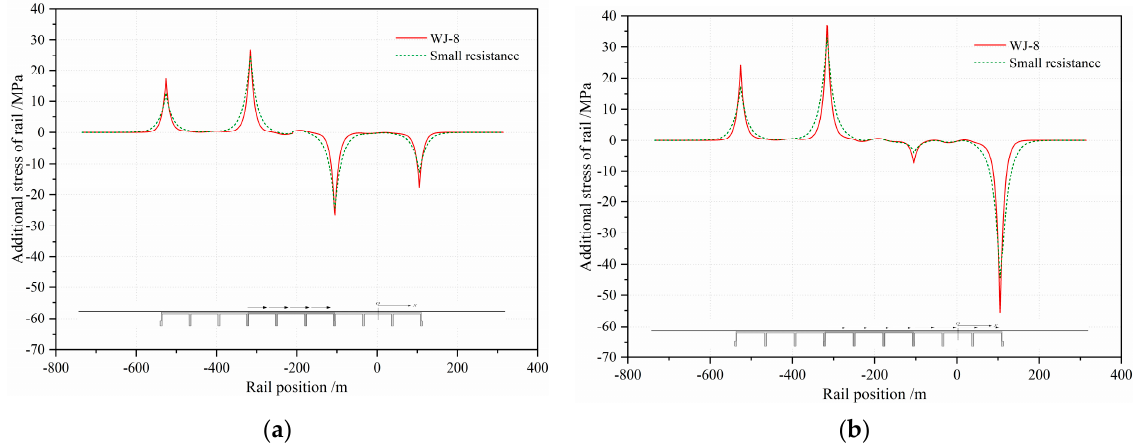
Figure 12. Additional braking force of rails under different braking conditions: ( a ) condition I; ( b ) condition II.